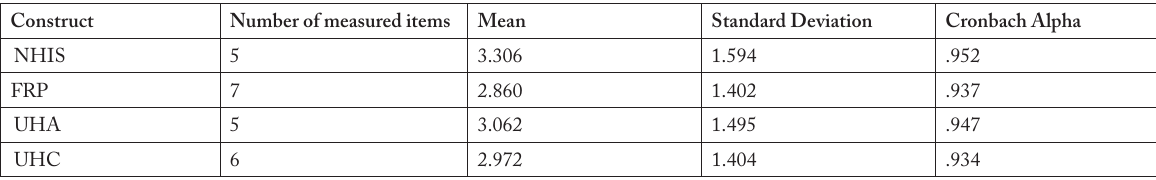
Table 3. Measured items and reliability